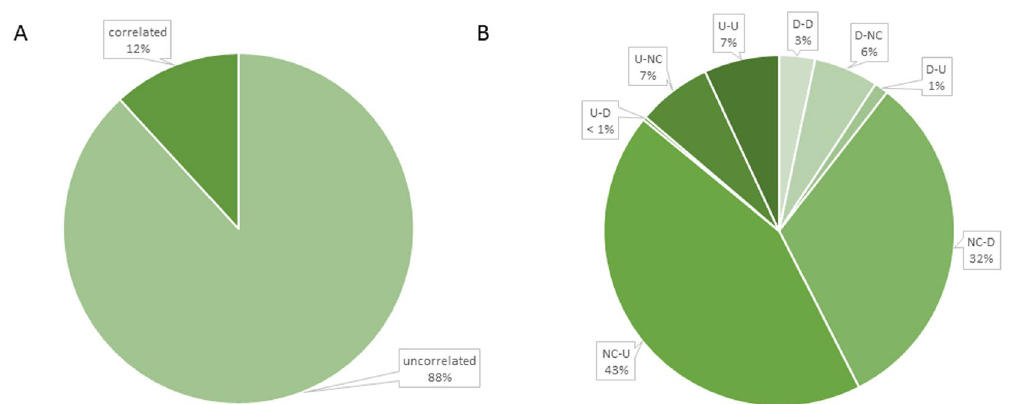
Figure 3. Pie chart showing the distribution of genes in correlated and uncorrelated groups. ( A ) The combined percentage of genes displaying correlated changes (U-U, D-D, D-U, and U-D) and uncorrelated changes (NC-D, NC-U, D-NC, and U-NC) in mRNA and protein levels between the OV and OM. ( B ) The percentage of genes in each subgroup of correlated and uncorrelated